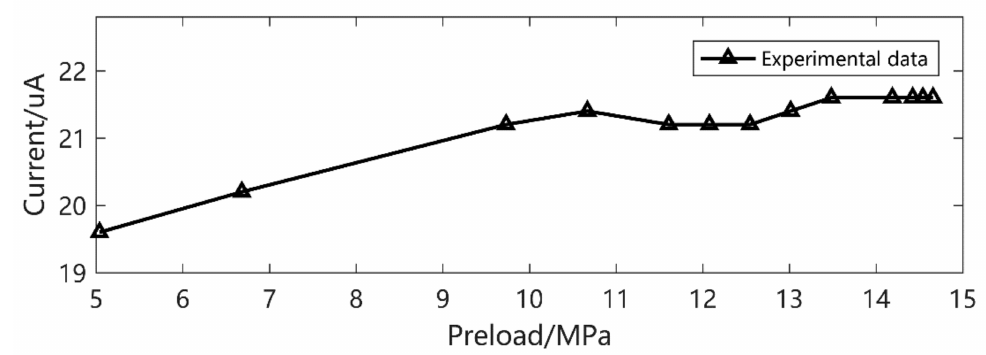
Figure 8. Frequency 30 Hz, excitation 11.72 MPa current